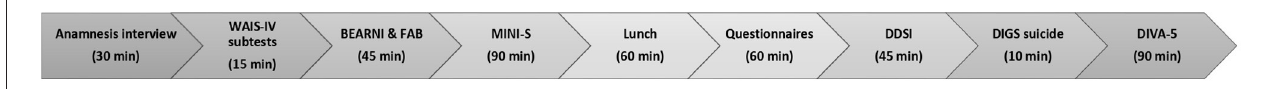
FIGURE 1 | Evaluation procedure. WAIS-IV, Wechsler Adult Intelligence Scale fourth edition; BEARNI, Brief Evaluation of Alcohol-Related Neuropsychological Impairment; FAB, Frontal Assessment Battery; MINI-S, Mini International Neuropsychiatric Interview DSM-5 edition; DDSI, Dual Diagnosis Screening Instrument; DIGS, Diagnostic Interview for Genetic Studies, suicide module; DIVA-5, Diagnostic Interview for ADHD DSM-5